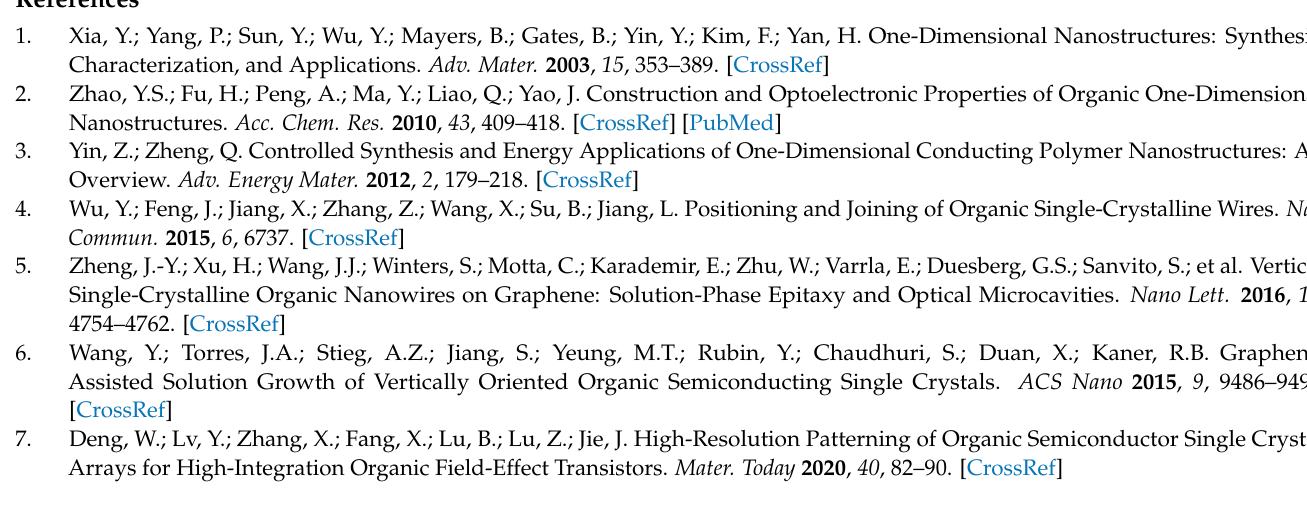
C 60 powder. Figure S2: SEM image of C 60 -RNRAs at different magnifications. Figure S3: SEM and TEM images of the detached C 60 nanorods from C 60 nanorod arrays that are subject to water and ultrasonication for 20 min. Figure S4: PXRD patterns of rubrene powder and rubrene crystals. Figure S5: FT-IR spectrum, Raman spectrum, and TG curve of rubrene. Figure S6: Full width at half maximum values for 210 and 311 peaks of C 60 NRs and C 60 -RNRAs obtained from their XRD patterns. Figure S7: Band diagrams of rubrene and C 60 . Figure S8: TEM and HRTEM images of the rubrene film. Figure S9: SEM images of as-obtained C 60 nanorod arrays using the concentration of rubrene in m -xylene of 0.5 and 2.0 mg mL − 1 . Figure S10: SEM images of (a) rectangle C 60 microsheets, (b) C 60 nanorods, and (c) rectangle C 60 -rubrene nanorod arrays. Figure S11: SEM images of (a) hexagonal C 60 microsheets, (b) C 60 nanorods, and (c) C 60 -rubrene nanorod arrays. Figure S12: XRD patterns of rectangle C 60 microsheets, rectangle C 60 -rubrene nanorod arrays, hexagonal C 60 microsheets,